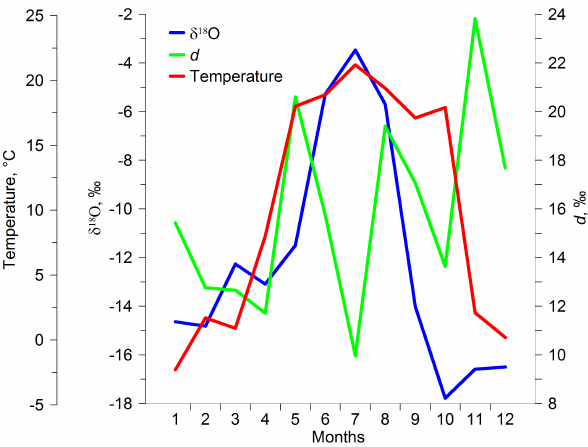
Figure 7. Monthly δ 18 O (blue line), d (green line), and air tem- perature (red line) data at the Bakuriani GNIP station in 2009 (see Table 1 for information on station and Fig. 1 for its location). Note that there is no clear seasonal cycle in deuterium excess, in contrast with δ 18 O, which shows maximum values in summer and minimum values in